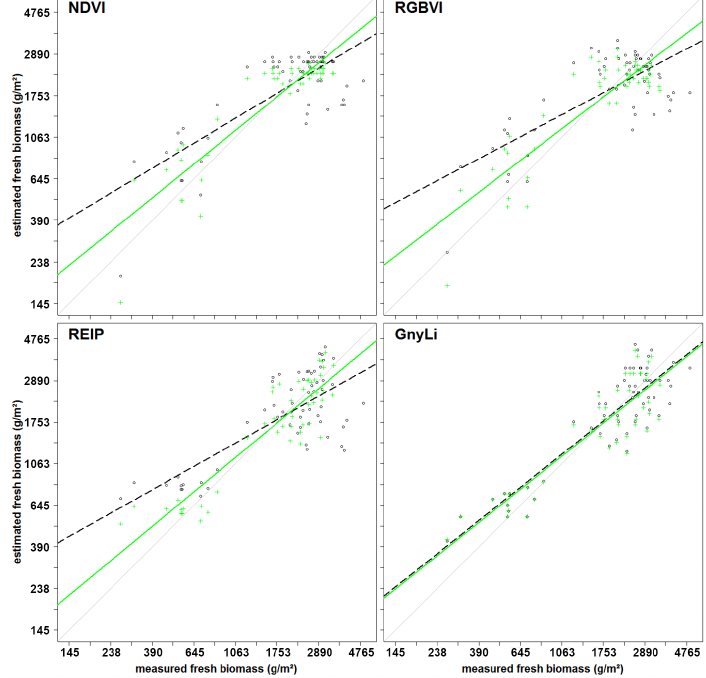
Figure 2. Correction of Figure 6 [1]. Scatterplots of measured vs. estimated fresh biomass for one validation data set for NDVI, RGBVI, REIP, and GnyLi (exponential model). Pre-anthesis: crosses and solid green line; whole observed period: circles and dashed black line; 1:1 line: light grey.